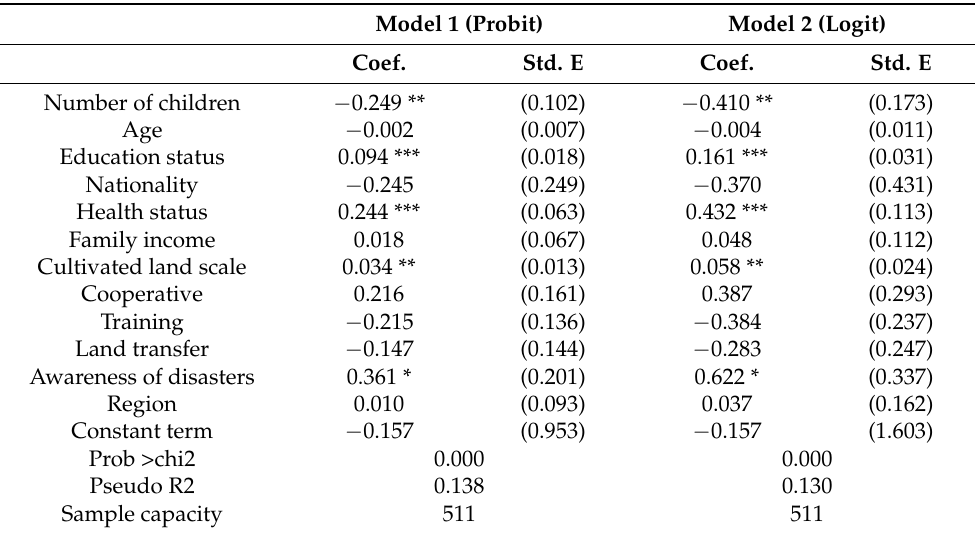
Table 3. Estimation results of the impact of the number of children on the adoption of soil and water conservation technologies by